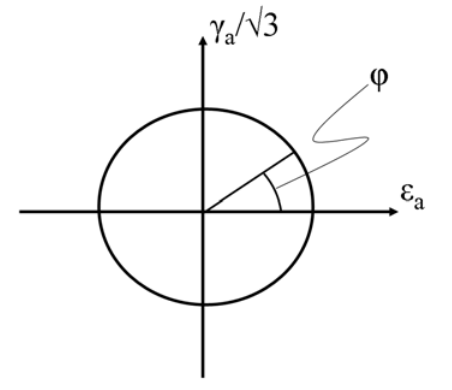
Figure 4: Definition of angle between axial and shear strain